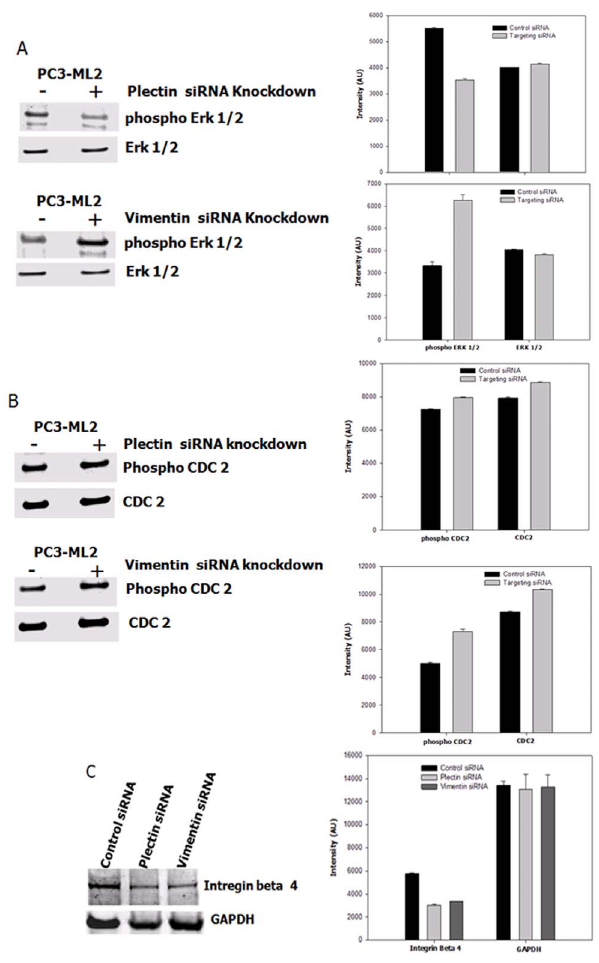
Figure 8. Plectin and vimentin suppression modulate signal transduction events and pathways knockdown PC3-ML2 cells. A and B. The relative expression levels of each protein were compared to the amounts in the control siRNA. There is a decrease of p-Erk 1/2 in the plectin knockdown cells compared to the controls, and an increase in p-Erk1/2 in the vimentin knockdown cells compared to the controls. C. Integrin beta 4 is suppressed in both the plectin and vimentin transfected cells.